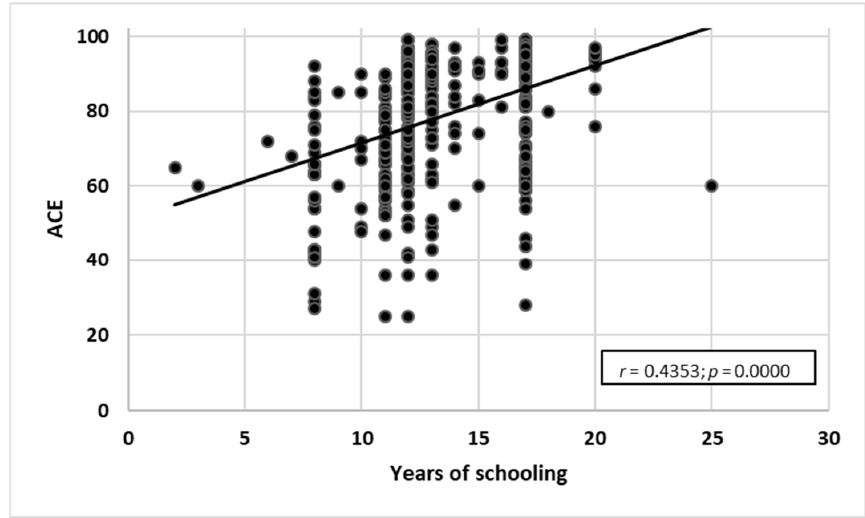
Figure 4. Years of schooling correlated with ACE-III test results ( n = 386).